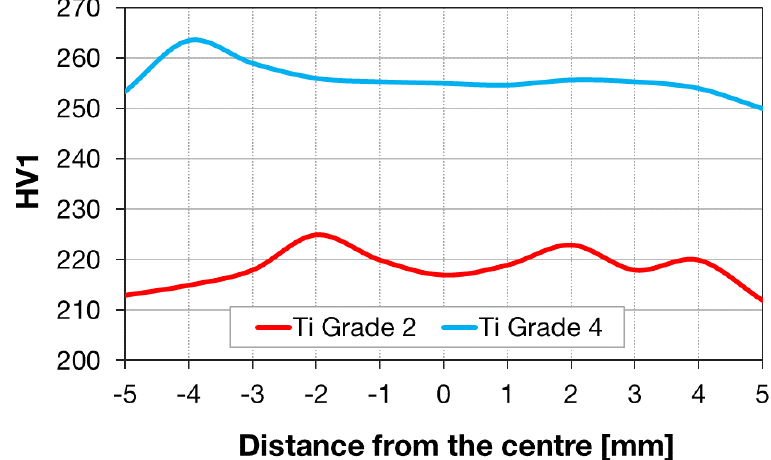
Figure 4. Distribution of the hardness on the transverse cross-section through the workpiece (one Conform SPD pass).